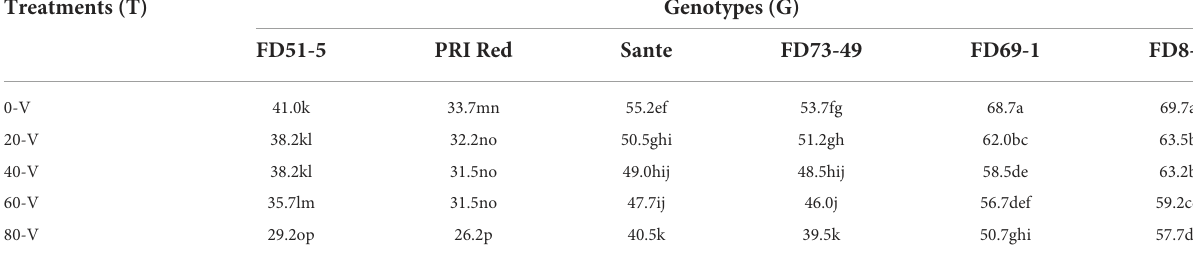
TABLE 3B Mean comparison of dormancy duration of potato in 2019 under direct electric current and genotype interactive effects.